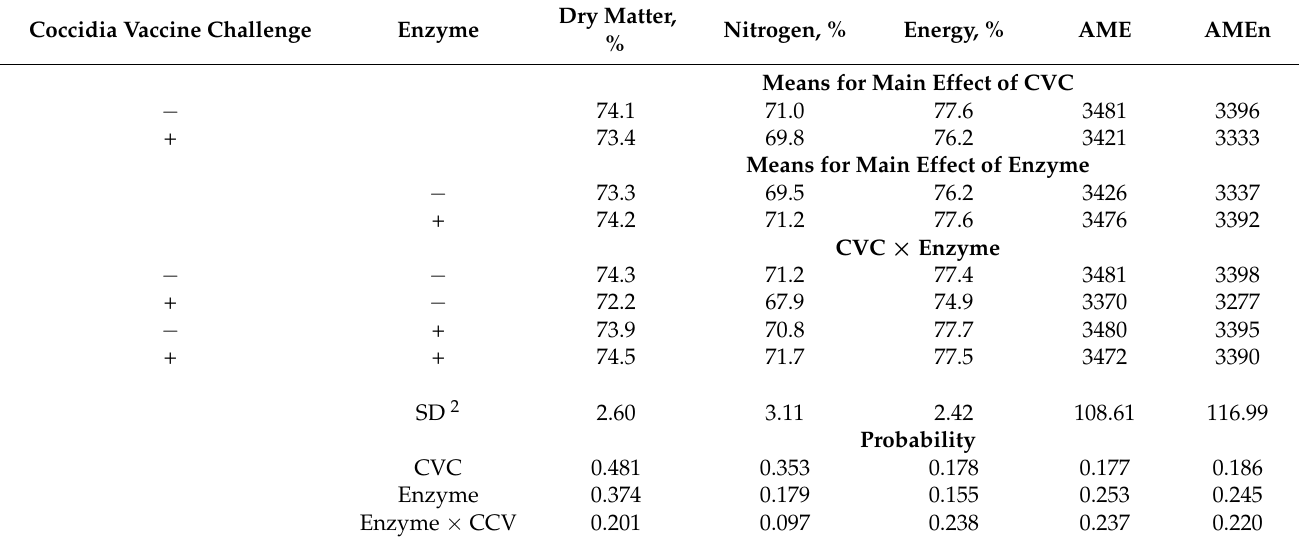
Table 5. Main and simple effects of coccidia vaccine challenge (CVC) and exogenous enzyme supplementation on nutrient and energy retention, apparent metabolizable energy (AME), and apparent metabolizable energy corrected for nitrogen (AMEn) in 28-day-old broiler chickens fed corn-soybean meal-based diets (14-day post-challenge) 1 . Coccidia Vaccine Challenge